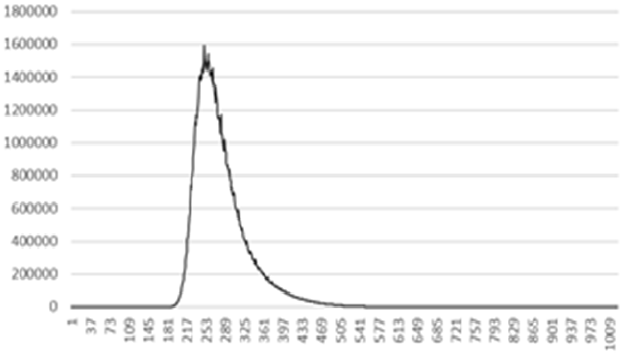
Fig. 6. The original distribution of the noise